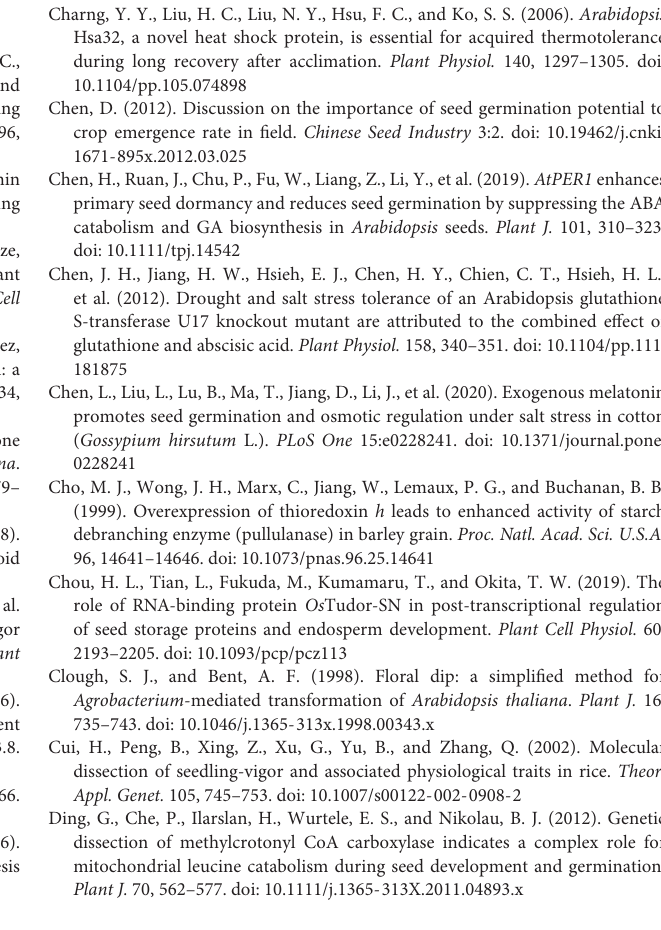
Supplementary Figure 1 | Heat map of the expression of candidate genes in different tissues, including cotyledon, root, and seed at different time periods on the A-subgenome. Supplementary Figure 2 | Heat map of the expression of candidate genes in different tissues, including cotyledon, root, and seed at different time periods on the